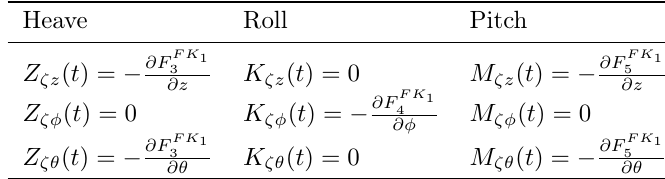
Table 4: 2 nd -order hydrostatic restoring coefficients due to wave